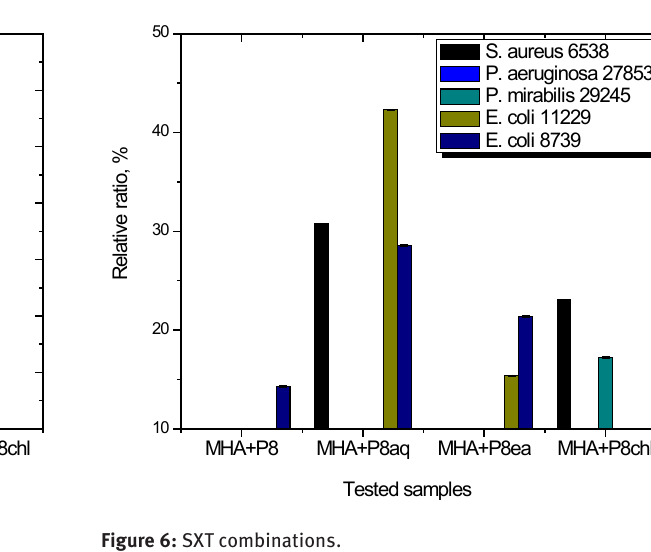
Figure 3: AM combinations.